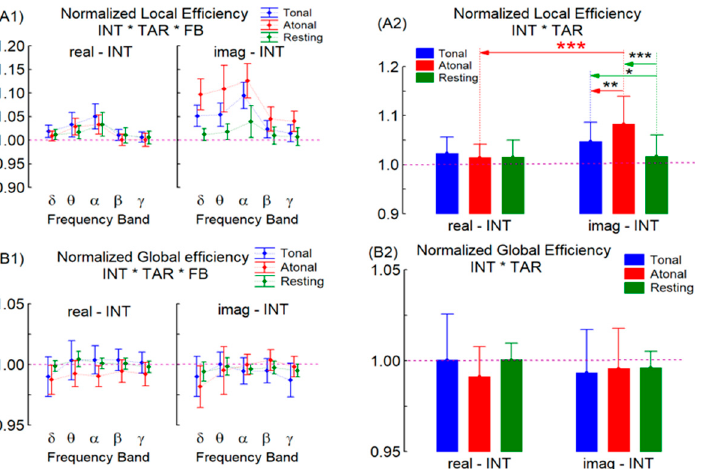
Figure 2. As in Figure 1, but for the normalized local ( A1 , A2 ) and global ( B1 , B2 ) efficiencies of the EEG graph/network. The red line indicates the limit value for a random network according to the selected normalization process. (* for p < 0.05, ** for p < 0.01, and *** for p <